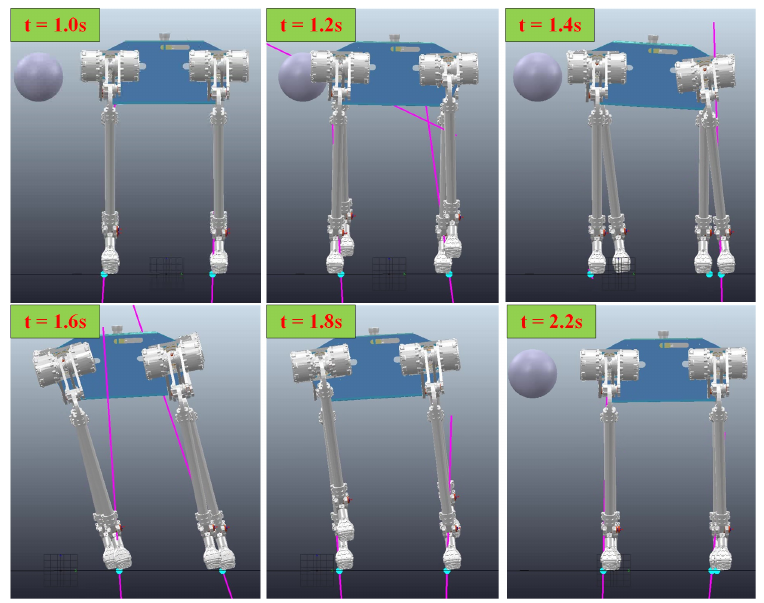
Figure 3. Snapshots of the disturbance recovery simulation.